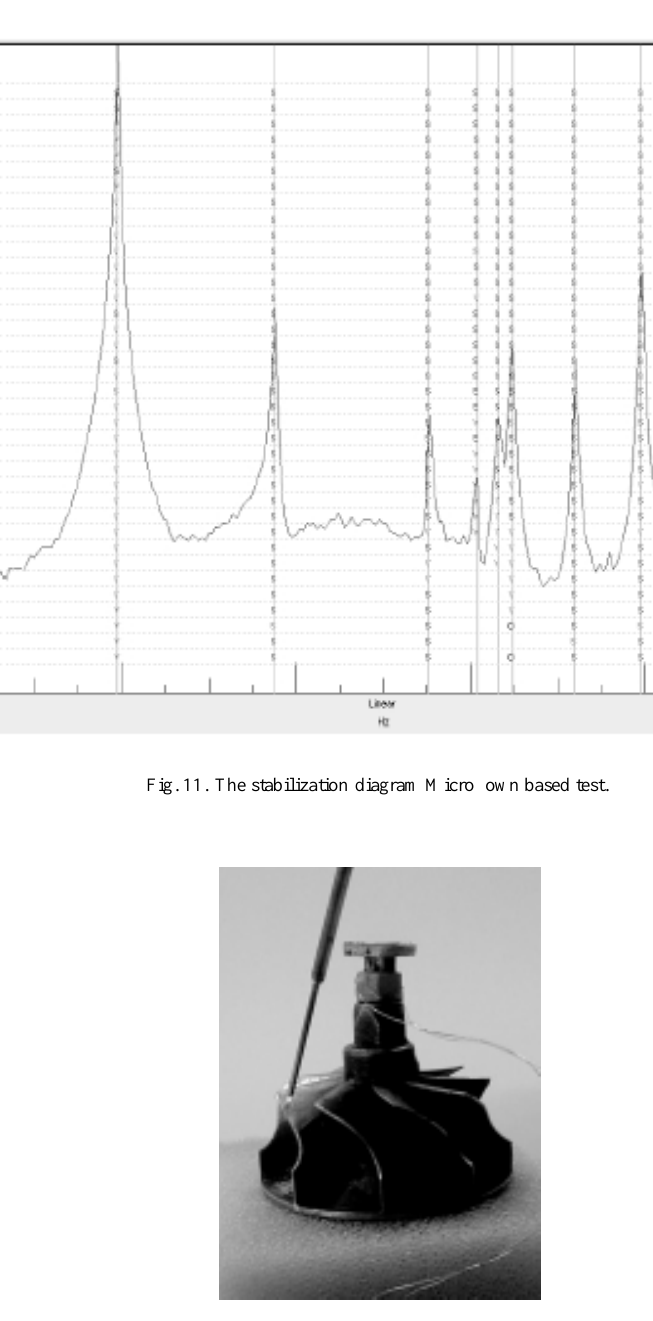
Fig. 12. Optical sensor and the micro